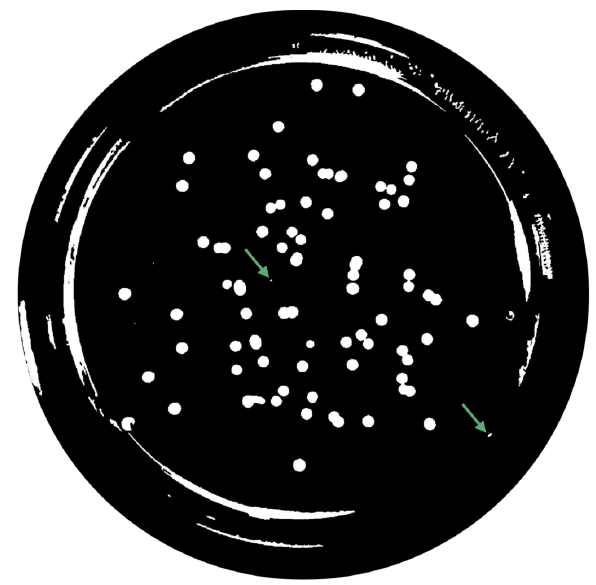
Figure 9. Extended-Maximum Transform.